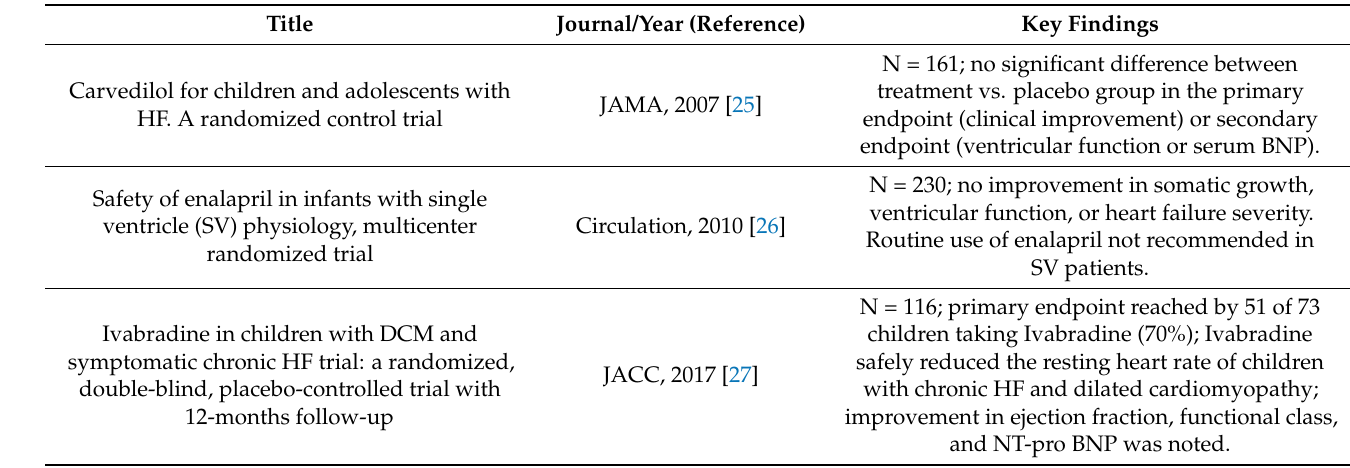
Table 1. Limited clinical trials in